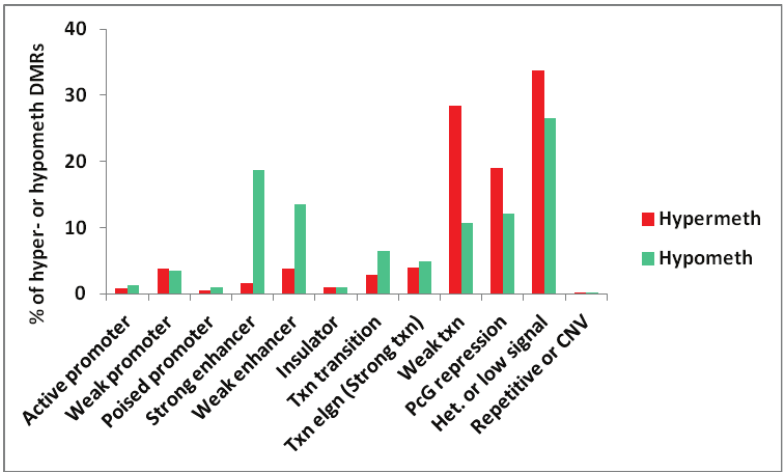
Figure 1. Genome-wide assessment of the type of chromatin segments overlapping MbMt- hypermethylated or hypomethylated DMRs. The percentages of all MbMt-hypermethylated DMRs and of all MbMt-hypomethylated DMRs (using the stringent criteria described in Methods) that overlap a given chromatin state [28] in Mb are shown. Active, weak, or poised promoter, chromatin enriched in H3K4me3; enhancer, chromatin containing H3K4me1 and H3K27Ac; PcG repression, chromatin marked by H3K27me3; Txn elgn, transcription elongation-type chromatin (also called Strong txn) enriched in H3K36me3; Het. or low signal, H3K9me3-type heterochromatin or low signal for H3K27Ac, H3K27me3, H3K4 methylation, H3K36me3, H3K79me2, H3K20me1, and CTCF binding; CNV, copy number